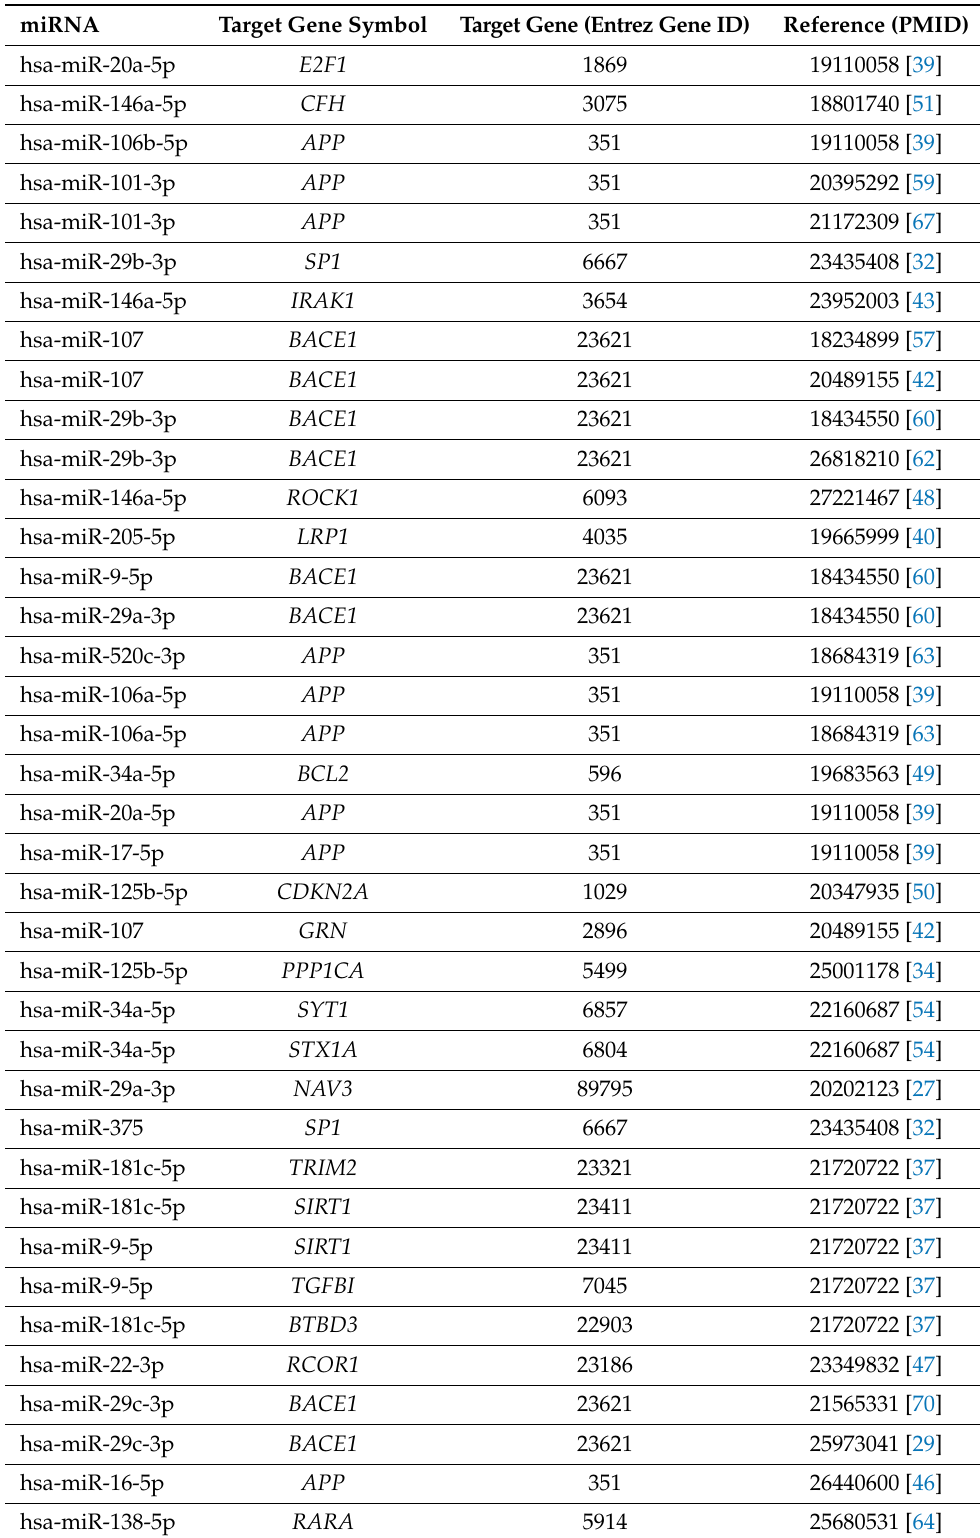
Table 1. Experimentally validated MTIs associated with AD obtained from miRTarBase and literature